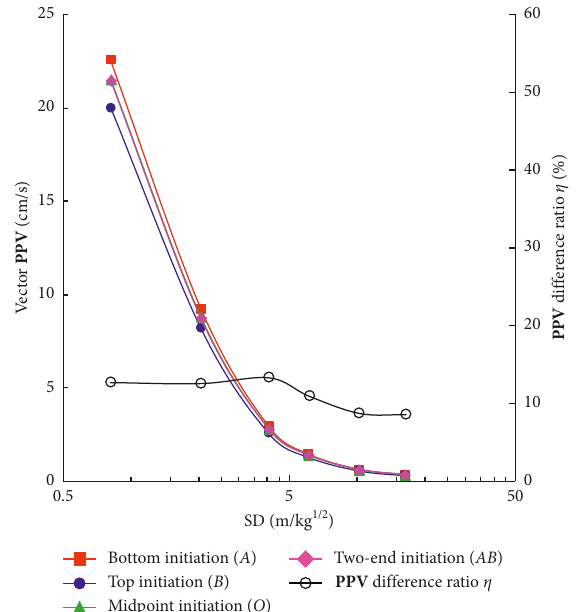
Figure 11: Illustration of the PPV difference ratio η observed along the axial direction of the cylindrical